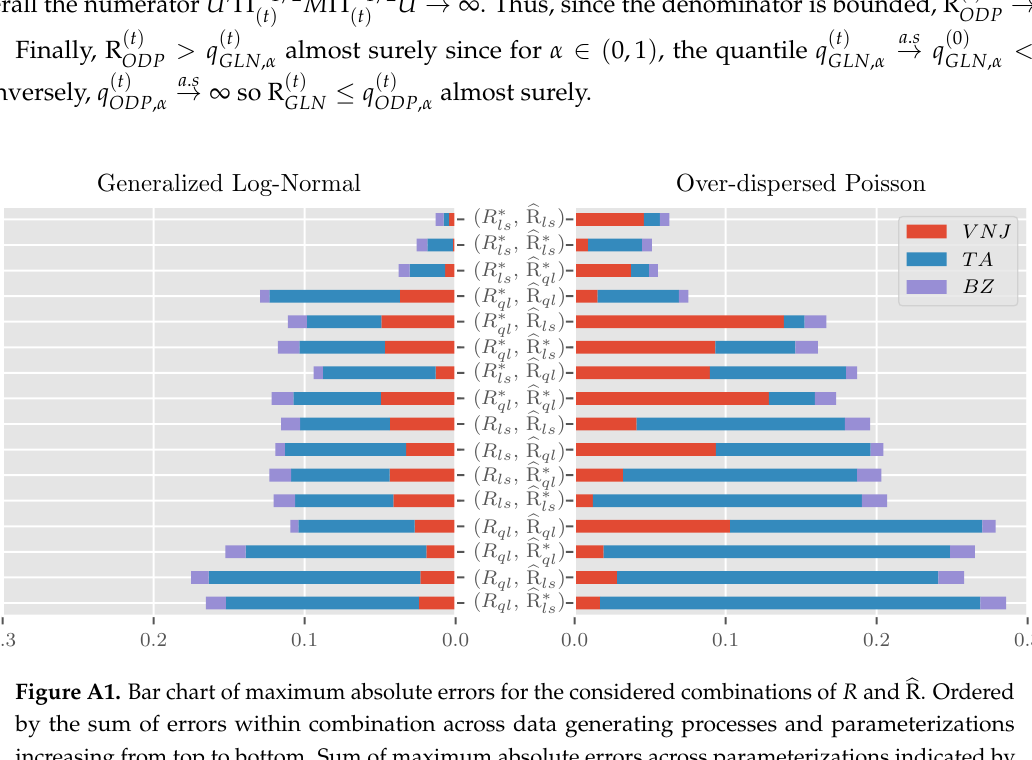
R. Ordered (cid:98)